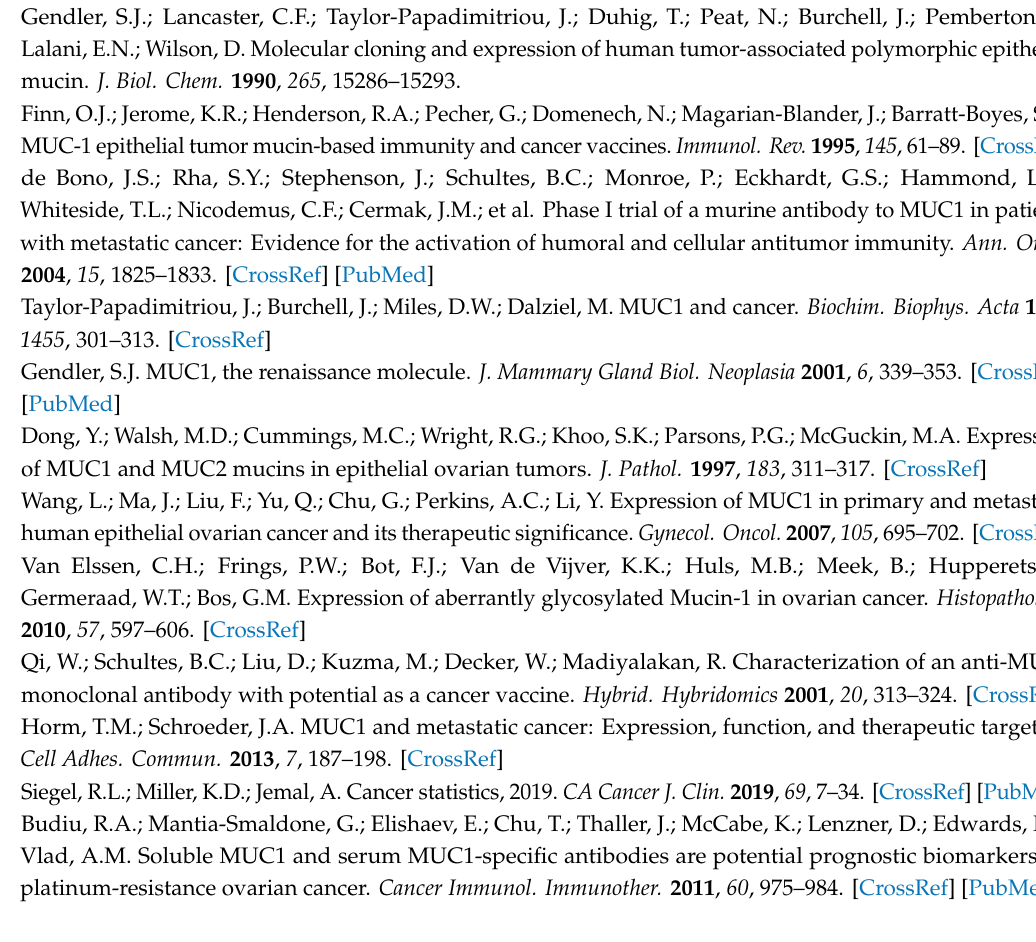
Supplementary Materials: The following are available online: Figure S1: Representative MALDI-ToF spectrum for AR20.5; Figure S2: Representative MALDI-ToF spectrum for DFO-AR20.5; Figure S3: Flow cytometry analysis of DFO-AR20.5 with SKOV3 human ovarian cancer cells; Figure S4: Stability of [ 89 Zr]Zr-DFO-AR20.5 in human serum at 37 ◦ C; Figure S5: Biodistribution data and PET images for athymic nude mice bearing orthotopic SKOV3-Red-FLuc xenografts; Table S1: Degree of labeling of DFO-AR20.5 as determined via MALDI-MS; Table S3: Tumor-to-background activity concentration ratios calculated using the biodistribution data from athymic nude mice bearing subcutaneous SKOV3 human ovarian cancer xenografts; Table S4: Biodistribution data from athymic nude mice bearing orthotopic SKOV3-Red-FLuc human ovarian cancer xenografts; Table S5: Tumor-to-background activity concentration ratios derived from the biodistribution data from athymic nude mice bearing orthotopic SKOV3-Red-FLuc human ovarian cancer xenografts; Table S6: Biodistribution data for the metastatic lesions collected from athymic nude mice bearing orthotopic SKOV3-Red-FLuc human ovarian cancer